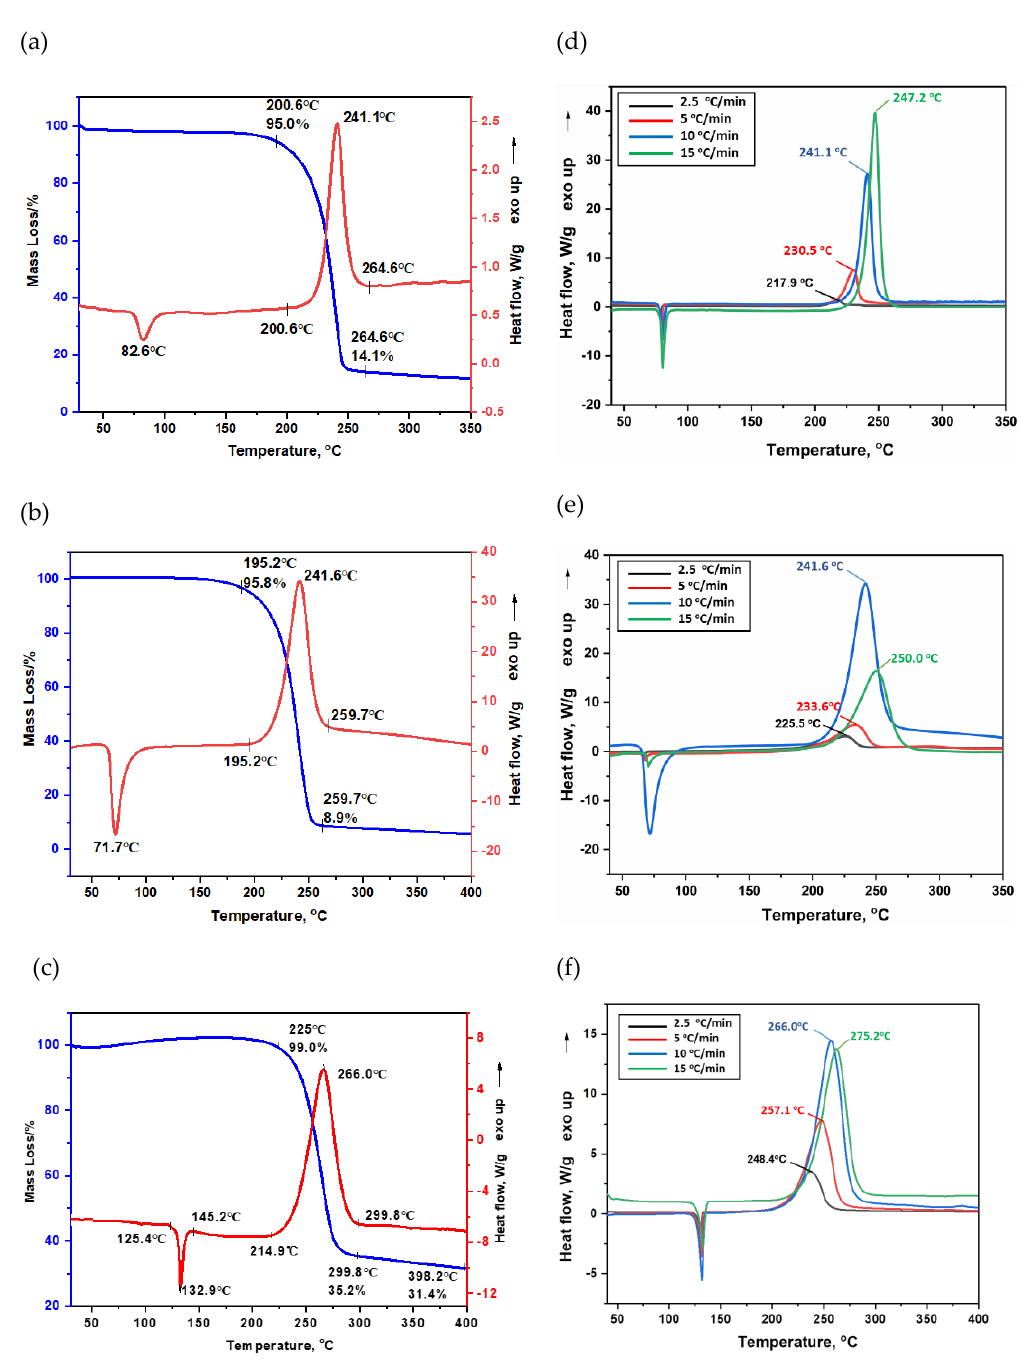
Figure 5. The DSC-TG traces of NTOM ( a ), NTOF ( b ) and NTOA ( c ); the DSC traces of NTOM ( d ), NTOF ( e ) and NTOA ( f ) obtained at different heating rates.